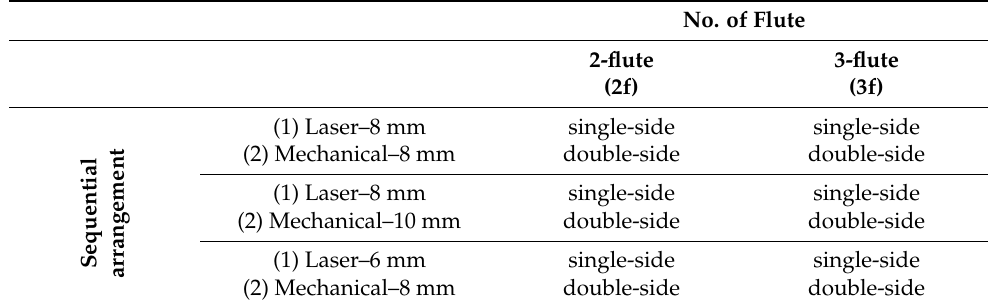
Table 3. The sequential drilling